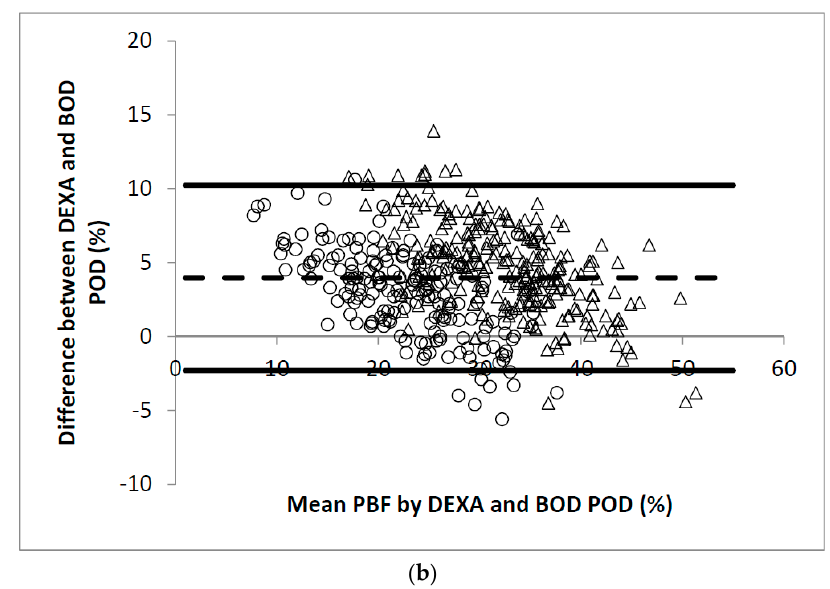
Figure 1. ( a ) Scatter plot of PBF calculated by DEXA and BOD POD in 445 participants. The Pearson’s correlation coefficient is 0.93; ( b ) Bland-Altman plot for data from ( a ). Men were represented by the open circles and women by the open triangles.